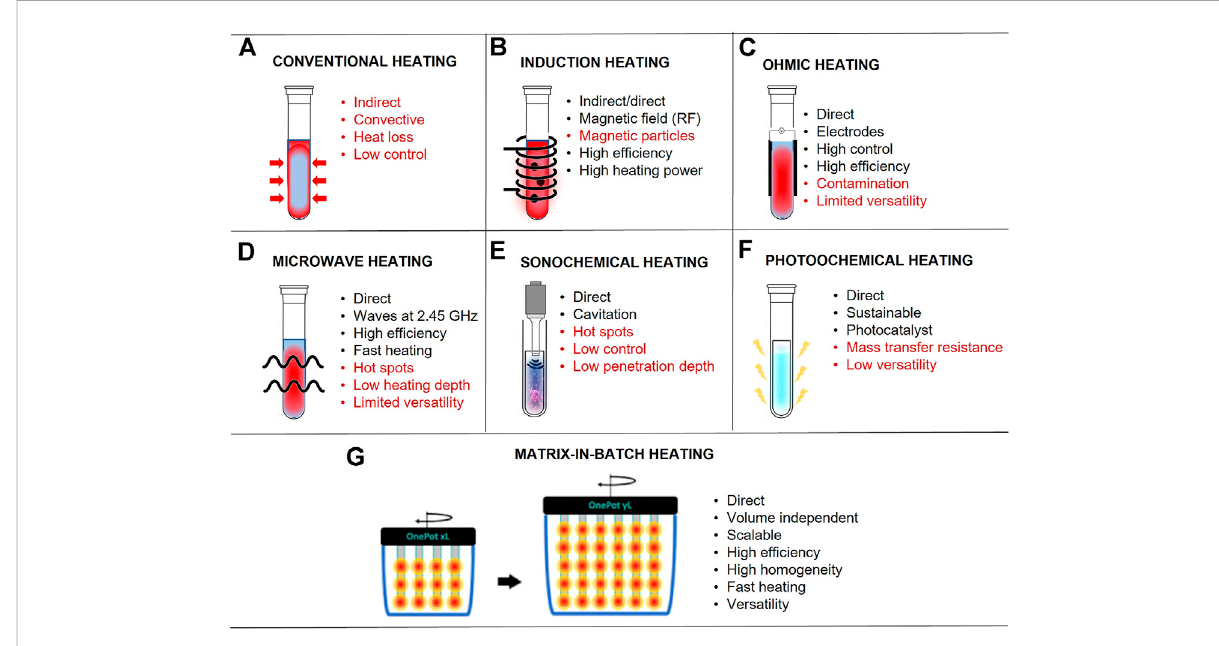
FIGURE 1 Schematic representation of Matrix-in-Batch heatingtechnology compared to other direct-heating